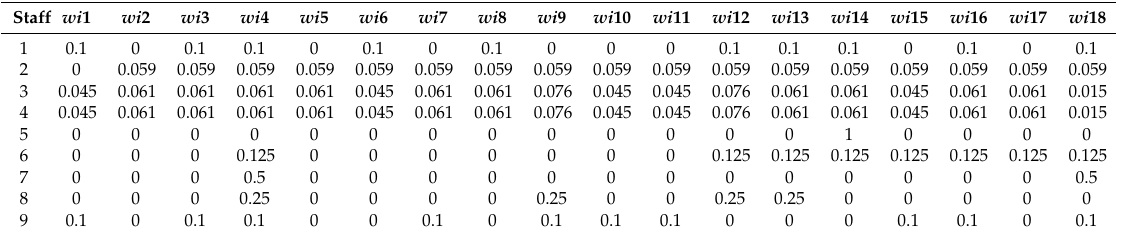
Table 7. Weight coefficient of the personality advantage characteristics of the top 9 personnel.